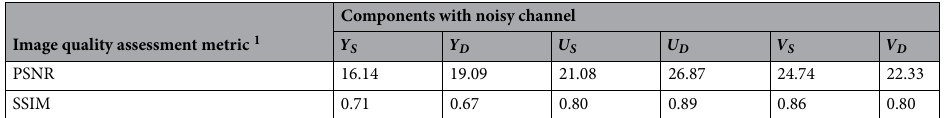
Table 11. The quality of the reconstructed image when one component is transmitted in the binary erasure channel. The experimental results are obtained on the DRIVE dataset.